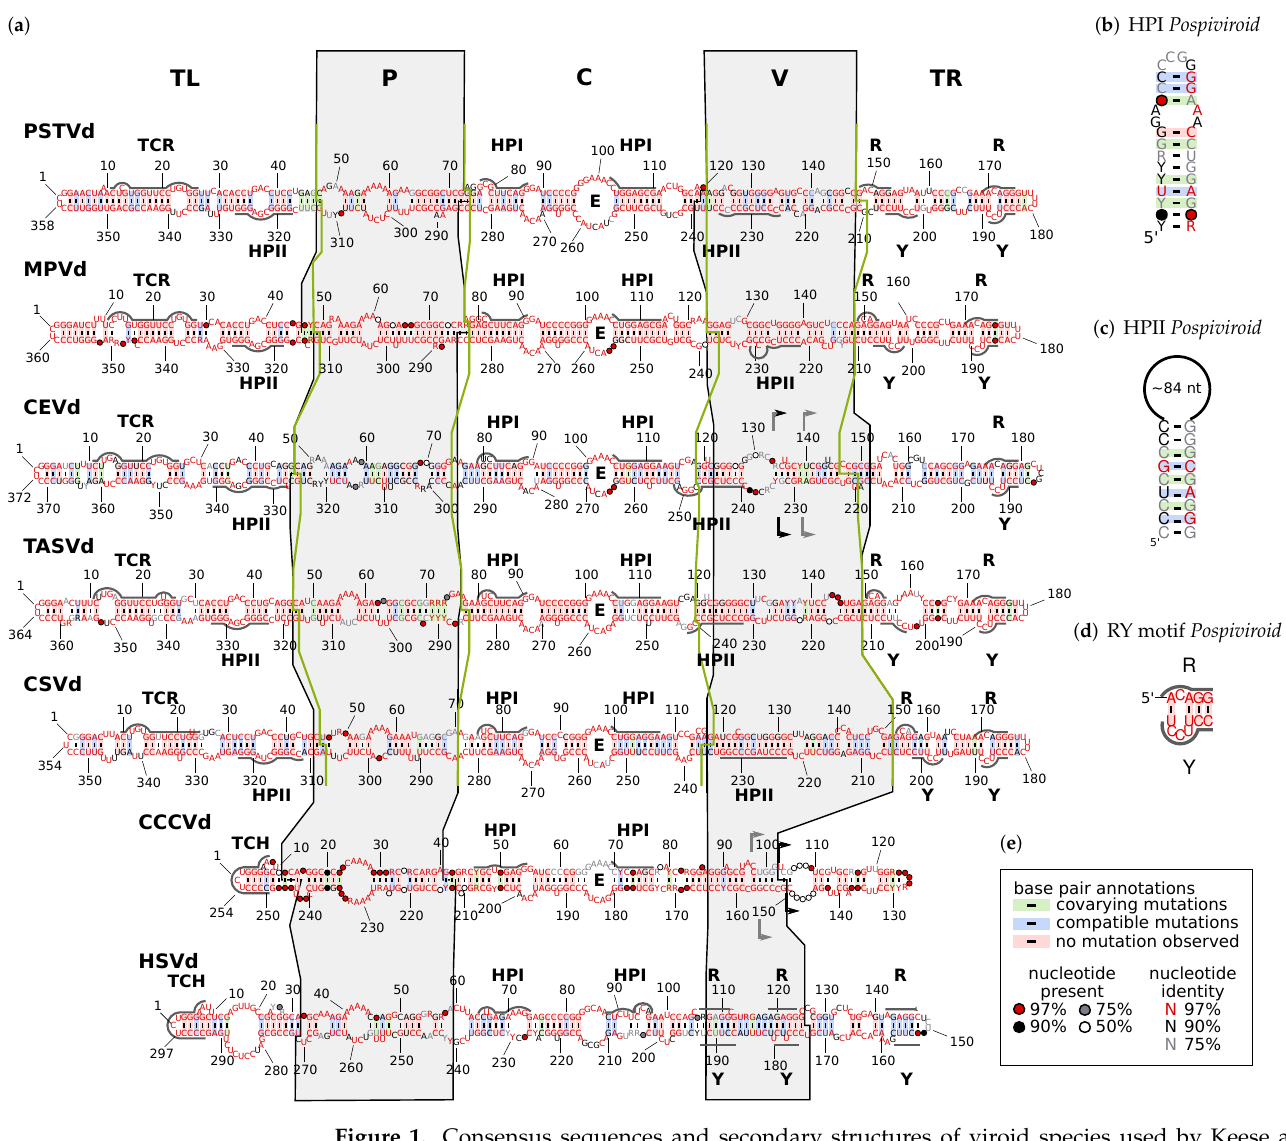
Figure 1. Consensus sequences and secondary structures of viroid species used by Keese and Symons [11,52] to determine the domain boundaries. Sequence alignments were produced by MAFFT X-INS- I [53]. Consensus structures were generated by C ON S TRUCT [54]. Consensus se- quences and drawings were produced by R2R [55]. The color code used by R2R is explained in box ( e ); a co-varying position has Watson–Crick pairs that differ at both nucleotide positions among sequences; if only one position differs, the occurrence is classified as a compatible mutation [56]. Note that no basepair annotated as “covarying” or “compatible” is statistically significant according to the analysis by R- SCAPE [57]. ( a ) Domain names are given at top: TR, terminal right; P, pathogenicity; C, central; V, variable; TL, terminal left. The P and V domains given by [52] are marked by black lines and gray background; the “consistent” domains are marked by green lines (see Section 3.2). For viroid names, see Table S1. E, loop E (Figure S22b); HPI, the two sequence regions form hairpin I in metastable structures of Pospiviroidae sequences (( b ); for further details see Figures S22a and S23; HPII, the two sequence regions form hairpin II in metastable structures of Pospiviroid sequences (( c ) and Figure S25); RY, binding motifs for VirP1 of Pospiviroid sequences (( d ) and Figure S26); TCR, terminal conserved region (Figure S20); TCH, terminal conserved hairpin (Figure S21). Flag pairs in CEVd and CCCVd mark examples of sequence stretches that are duplicated in natural variants